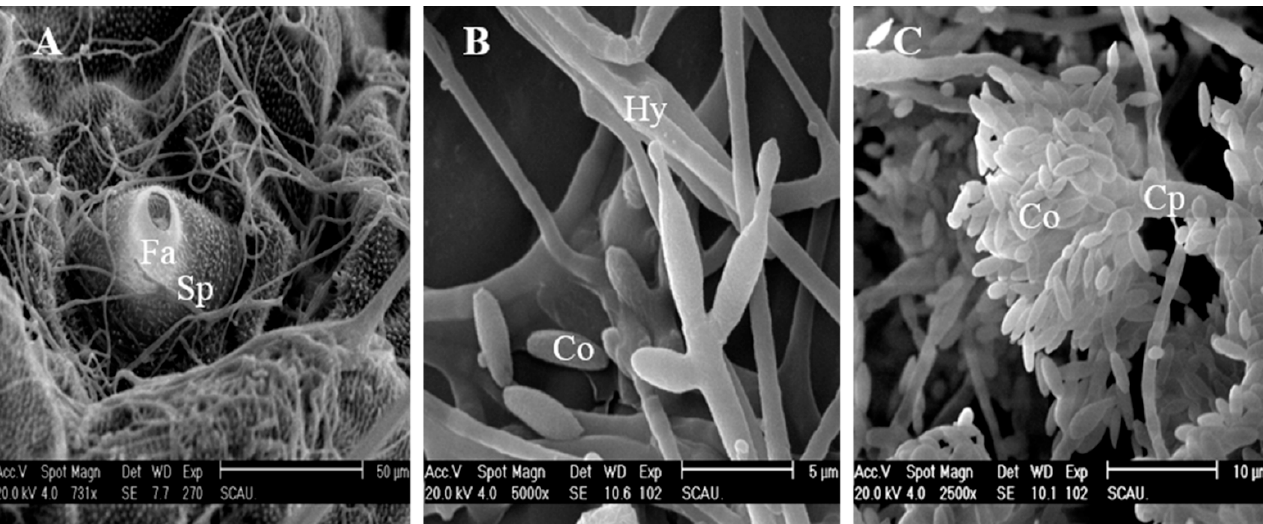
Figure 7. SEM photographs of conidia development of Cordyceps fumosorosea IFCF01 on the cuticle surface of Plutella xylostella larvae. ( A ) Development of hypha on the cuticle and around the spiracle (Sp) after 36 h post-inoculation. Fa = filter apparatus; ( B ) Hyphae developed, and differentiated to form a dense mycelial mass on the cuticle after 60 h post-inoculation; ( C ) Conidia development after 72 h post-inoculation, mature conidium (Co) is still attached to the conidiophores (Cp).